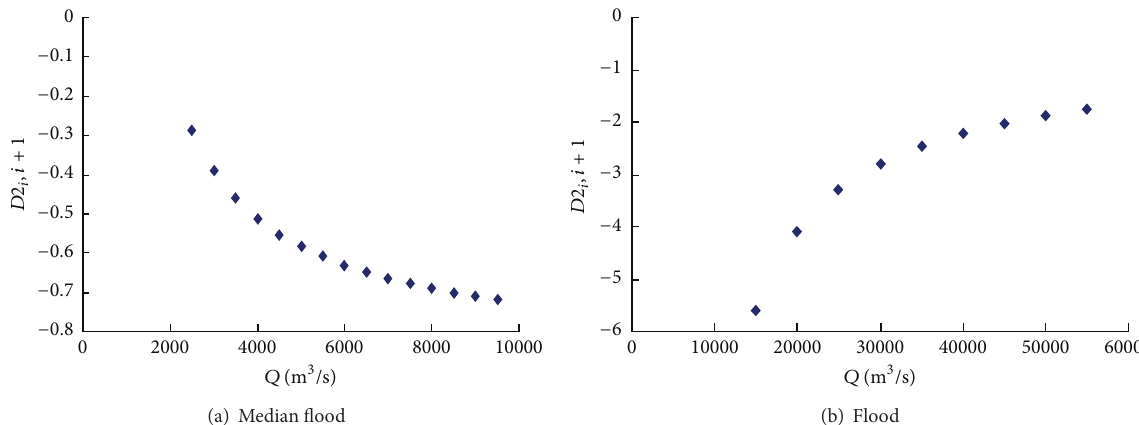
Figure 5: Second-order accumulated variable-dimensional fractal-flow discharge of Chongqing city of Yangtze River left bank.